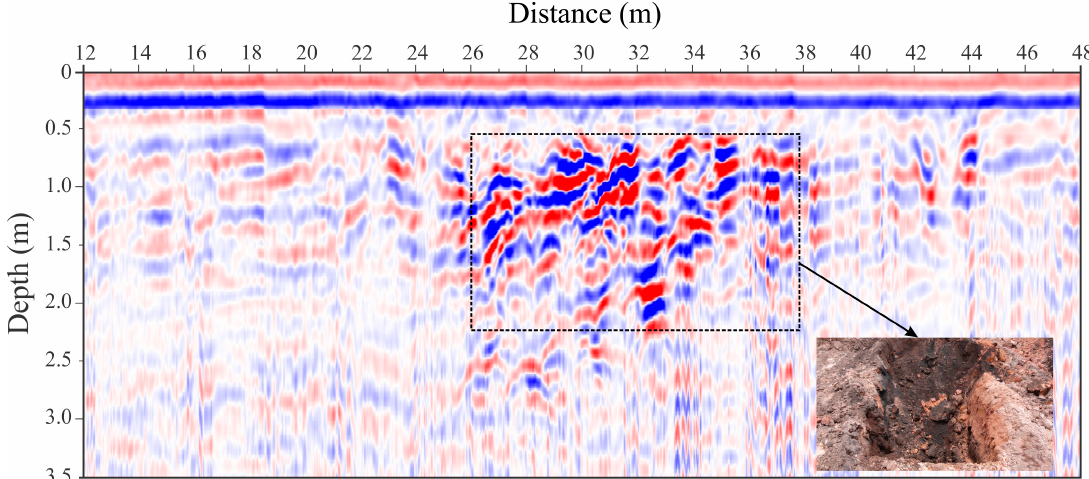
Figure 6. Segment of the GPR 1 profile of 200 MHz acquired in area 1. The black dashed rectangle highlights the anomalous region, and the photograph shows the friable iron ore found after the excavation.